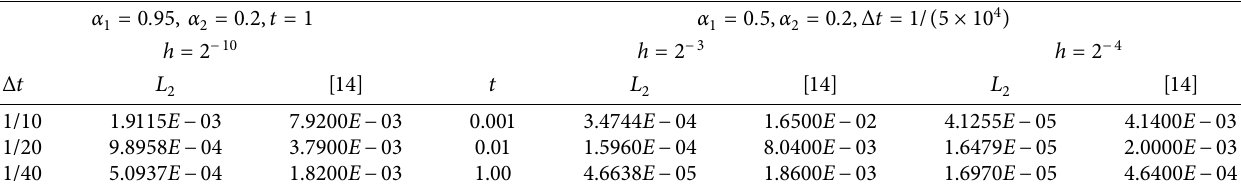
Table 2: Errors norm of Y at diferent step